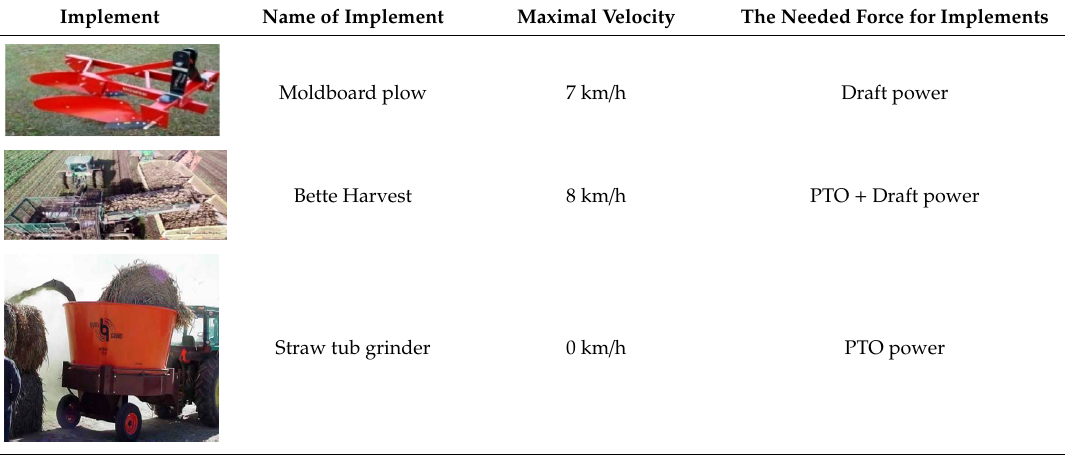
Table 2. Parameters of implements.